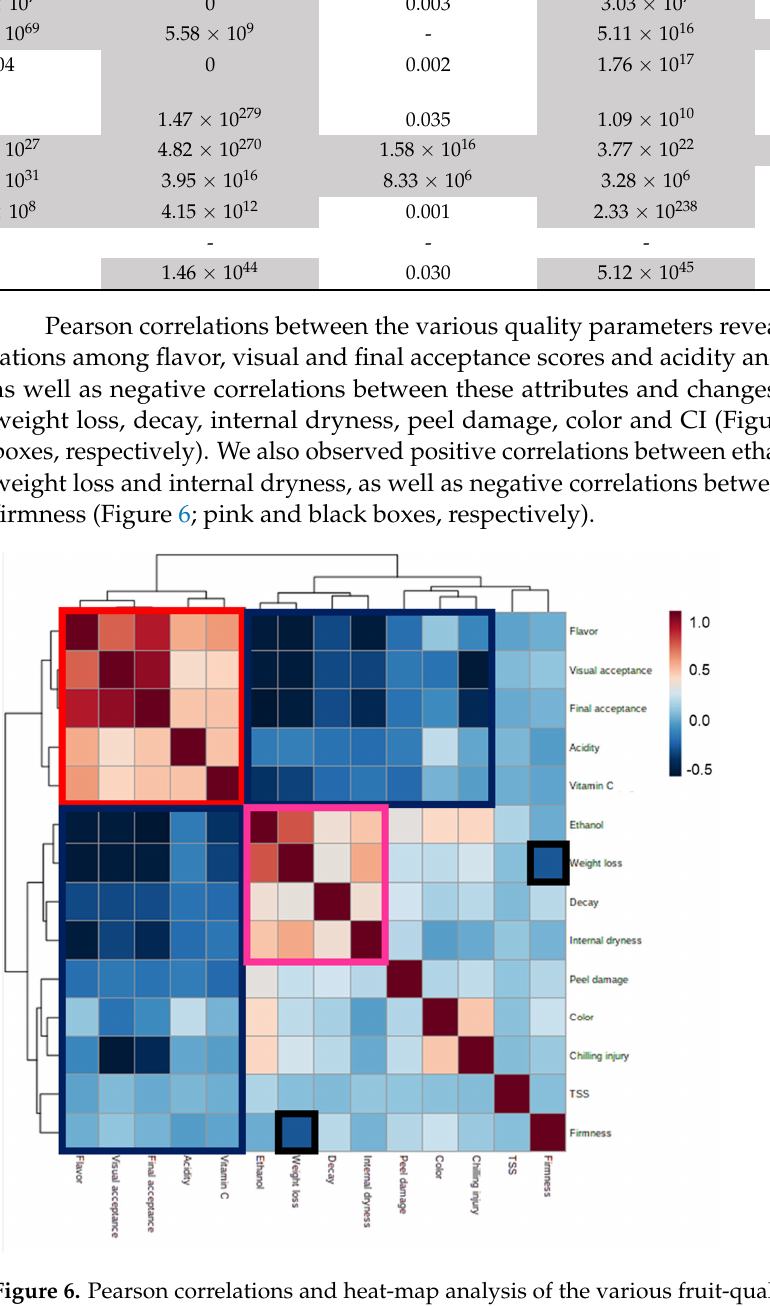
Figure 6. Pearson correlations and heat-map analysis of the various fruit-quality parameters. Red and pink boxes indicate parameters that are positively correlated with one another, and blue and black boxes indicate parameters that are negatively correlated with one another. Finally, Pearson correlations revealed positive correlations between final acceptance scores and acidity, vitamin C, flavor and visual acceptance scores, and negative correla ‐ tions between final acceptance scores and changes in TSS, firmness, color, peel damage, decay, CI, internal dryness, weight loss and ethanol accumulation (Figure 7).